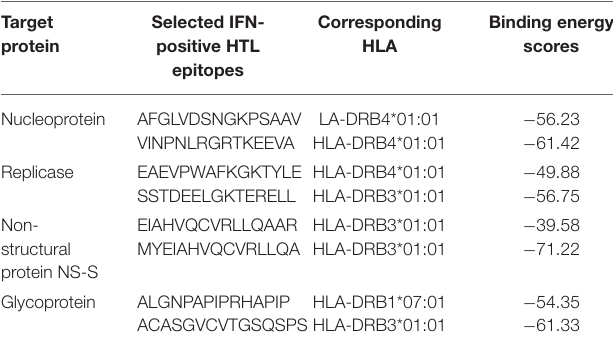
TABLE 5 | Corresponding HLA with higher binding affinity and docking scores obtained for each HTL epitope of the target RVFV